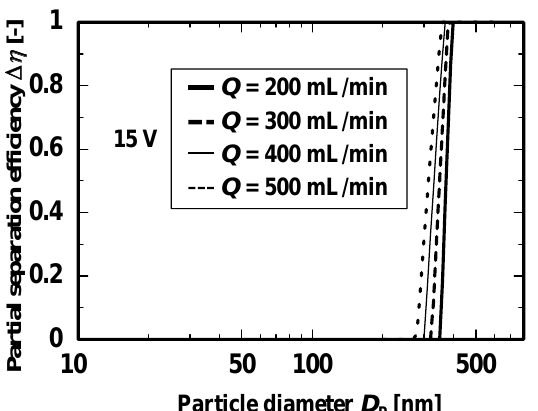
Fig. 9 Effect of flow rate on partial separation efficiency curves at the applied voltage of 15 V calculated according to Eq.(2).